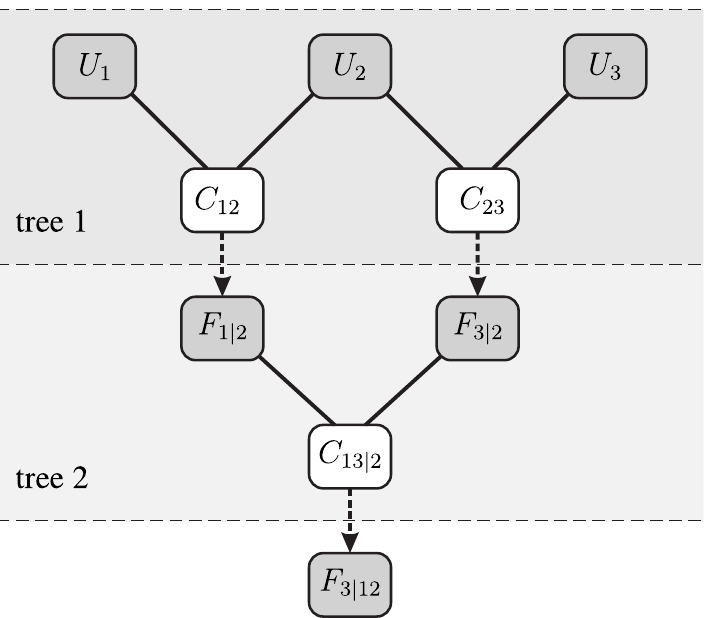
Figure 3. The principle of hierarchical nesting of bivariate copulas in the construction of a three- dimensional vine copula through conditional